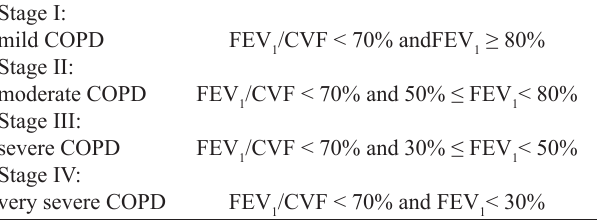
Table 1. Chronic obstructive pulmonary disease stage classification according to GOLD